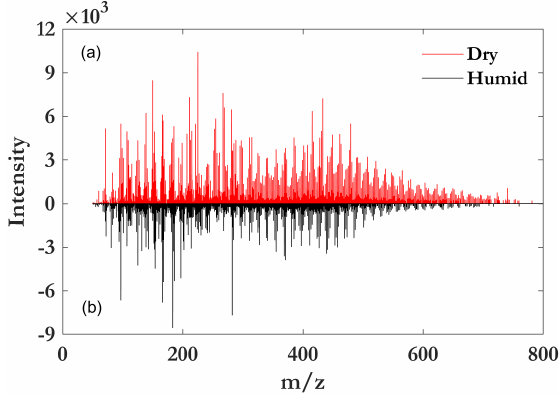
Figure 8. Positive ion mode ESI-Orbitrap mass spectra of SOA from isoprene-NO 2 irradiations under dry (a) and humid (b) con-